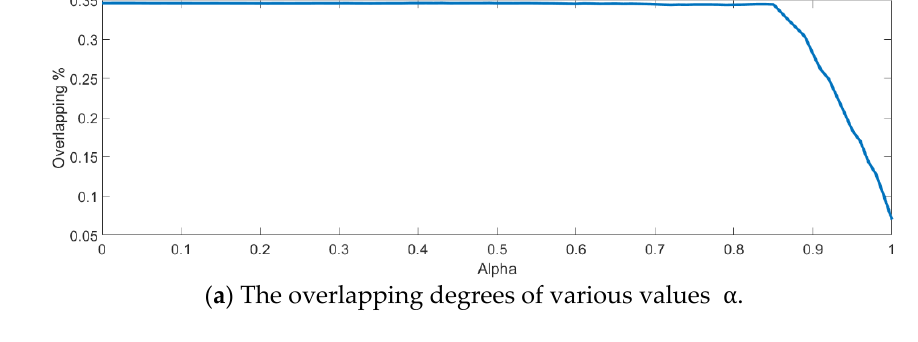
( a ) The overlapping degrees of various values α .